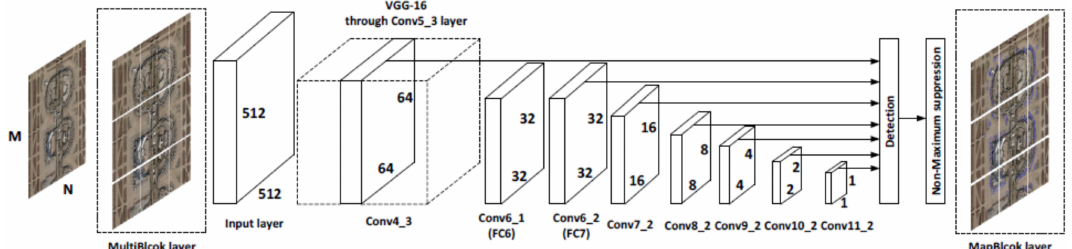
Figure 1. Airplane detection framework. We add a MultiBlock layer and MapBlock layer based on the SSD (Single Shot MultiBox Detector). After the MultiBlock layer, each block is resized to 512 × 512. As is shown, we use VGG (Visual Geometry Group) 16 as the base network. The prediction result of each block is mapped back to the original image after passing the MapBlock